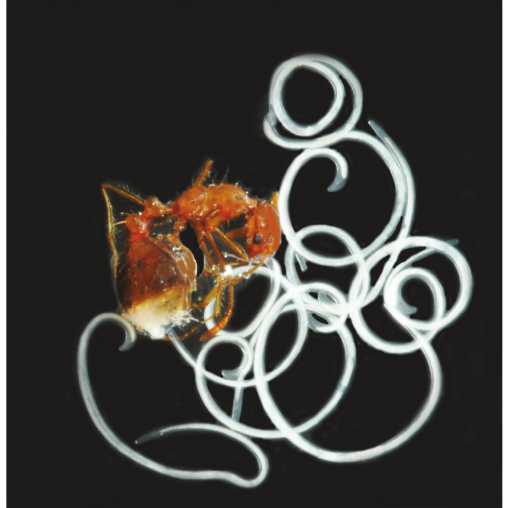
Figure 2: Parasitic juveniles of Allomermis solenopsi removed from the gaster of a fire ant worker. Photo courtesy of S. D. Porter, USDA- ARS.